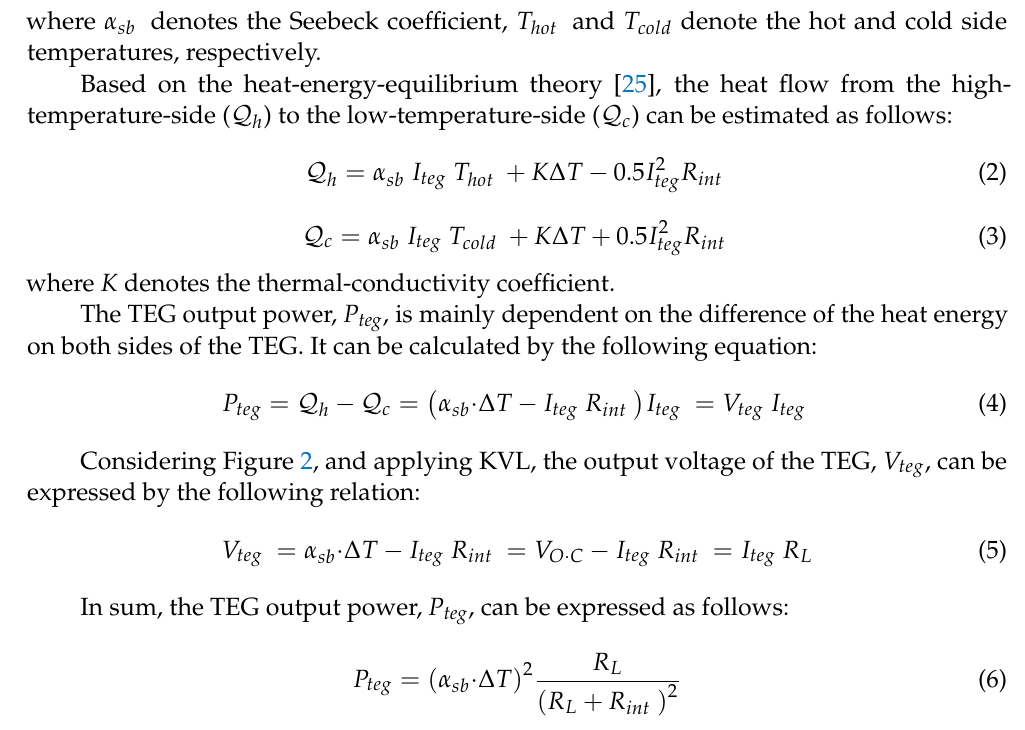
Figure 2. Simple equivalent-circuit of the TEG unit.